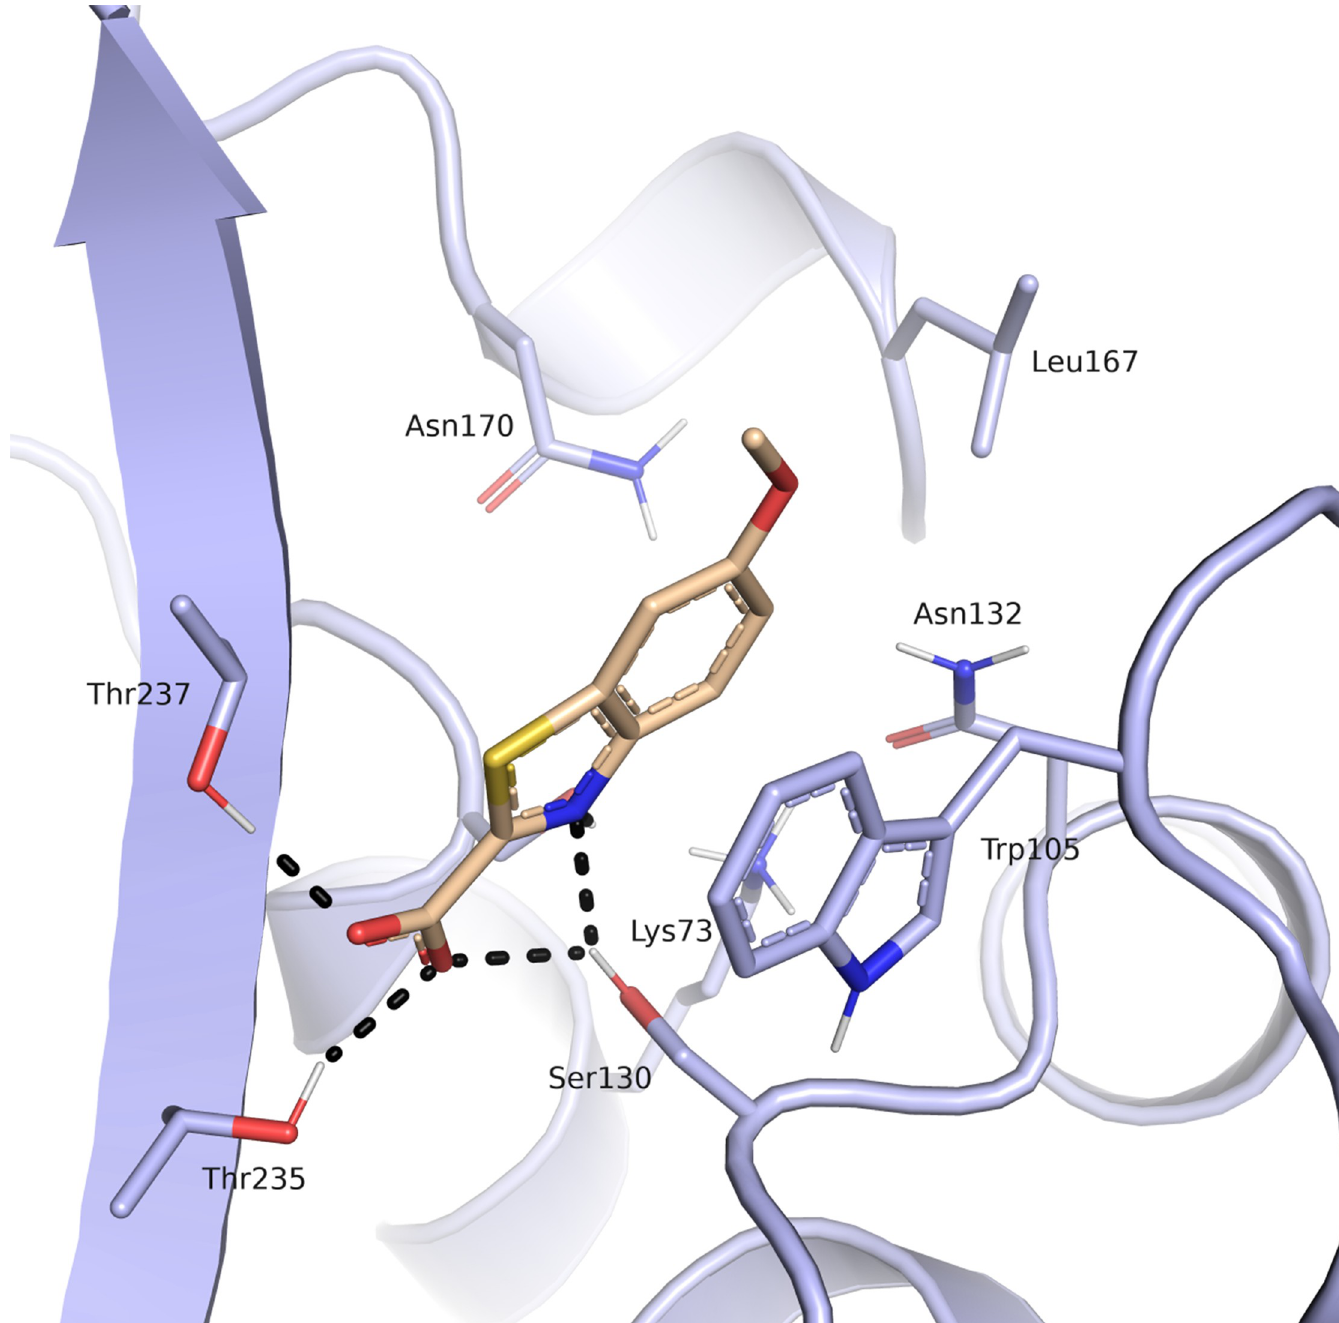
Fig 8. Predicted binding mode of compound 9a (beige) in the Kp KPC-2 receptor (blue). Putative hydrogen bond interactions are indicated as black dots (Ambler numbering)[21].